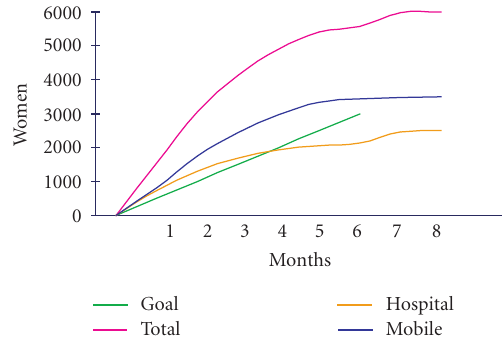
Figure 6: Recruitment—Roi Et trial project, 1999.